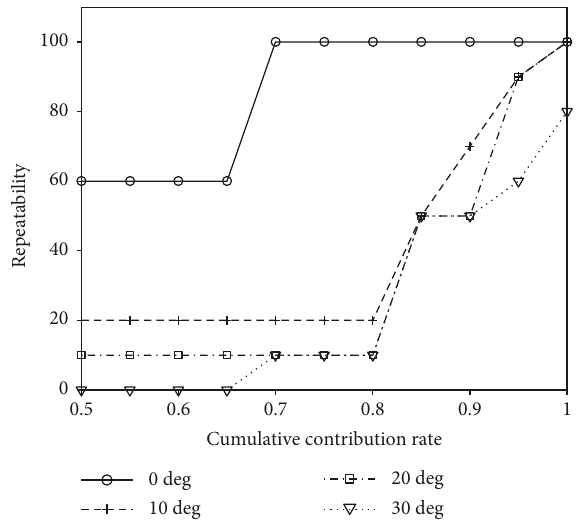
Figure 2: Repeatability for di ff erent cumulative contribution